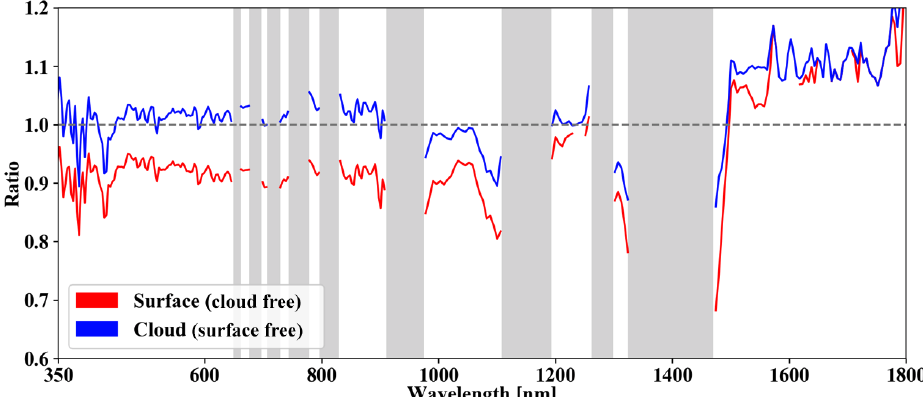
Figure 14. The spectrum of ratio when COT = 0 (red, indicating cloud-free) and when COT = ∞ (blue, indicating surface free) for wave- lengths range from 350 to 1800nm. The gas absorption bands are indicated in gray. Ratios at the gas absorption bands are